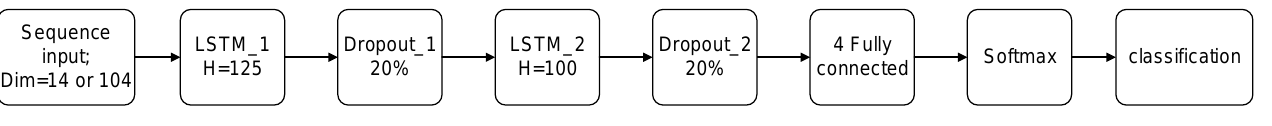
Figure 11. LSTM network